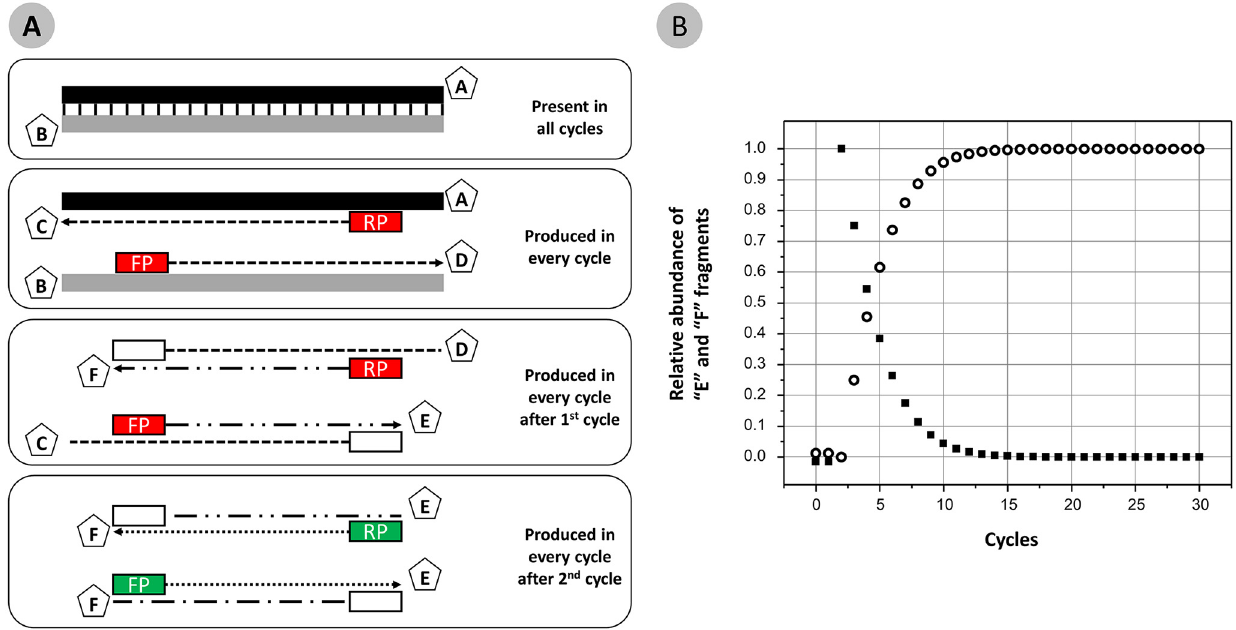
Fig 2. Types and abundance of DNA fragments found in PCR. (A) Template DNA fragments (containing strands “ A ” and “ B ” ) are added to PCR reactions and are conserved throughout the reaction. Fragments “ A ” and “ B ” serve as templates for copying in each cycle, with hybrid molecules “ C ” and “ D ” produced in a linear fashion each cycle. In cycles two and above, “ C ” and “ D ” are copied, creating hybrid molecules “ E ” and “ F ” in a linear fashion. In cycles three and above, the “ E ” and “ F ” fragments generated in prior cycles are copied into inverse complement fragments “ F ” and “ E ” , respectively, in an exponential fashion. Red boxes indicate ‘ natural ’ primer annealing to genomic DNA template or copy of gDNA template. Green boxes indicate ‘ artificial ’ primer annealing to primer sites that are copies of oligonucleotide primers added to the PCR mixture, and incorporated during previous cycles. (B) The relative abundance of “ E ” and “ F ” fragments generated by ‘ natural ’ template-primer interactions ( “ C ” , ” D ” ! “ E ” , ” F ” ; shown as solid squares) and by artificial template-primer interactions ( “ E ” , ” F ” ! “ F ” , ” E ” ; shown as open circles) varies by cycle. At the end of cycle two, all “ E ” and “ F ” fragments have been generated only by ‘ natural ’ template- primer interactions.